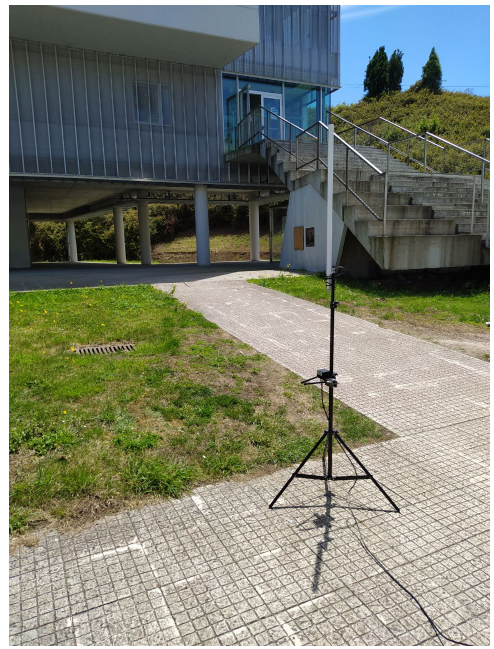
Figure 18. Location of the gateway antenna during the experiments at position